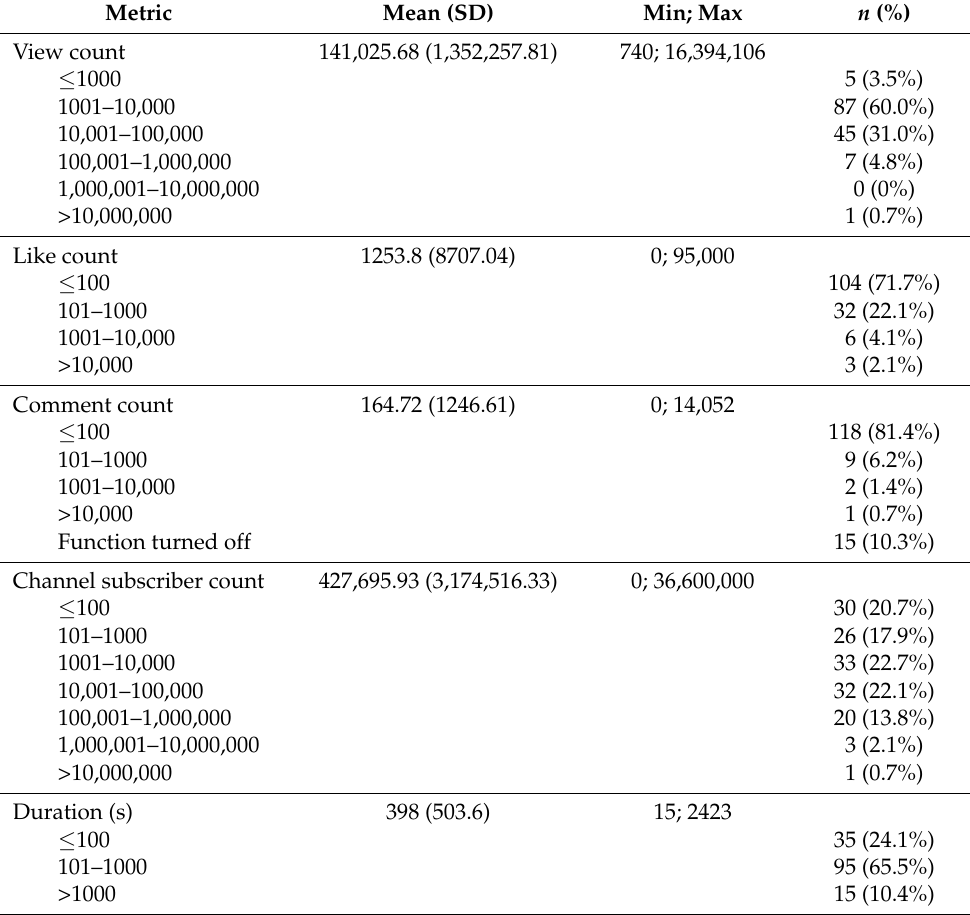
Table 1. Viewing metrics of the 145 videos.